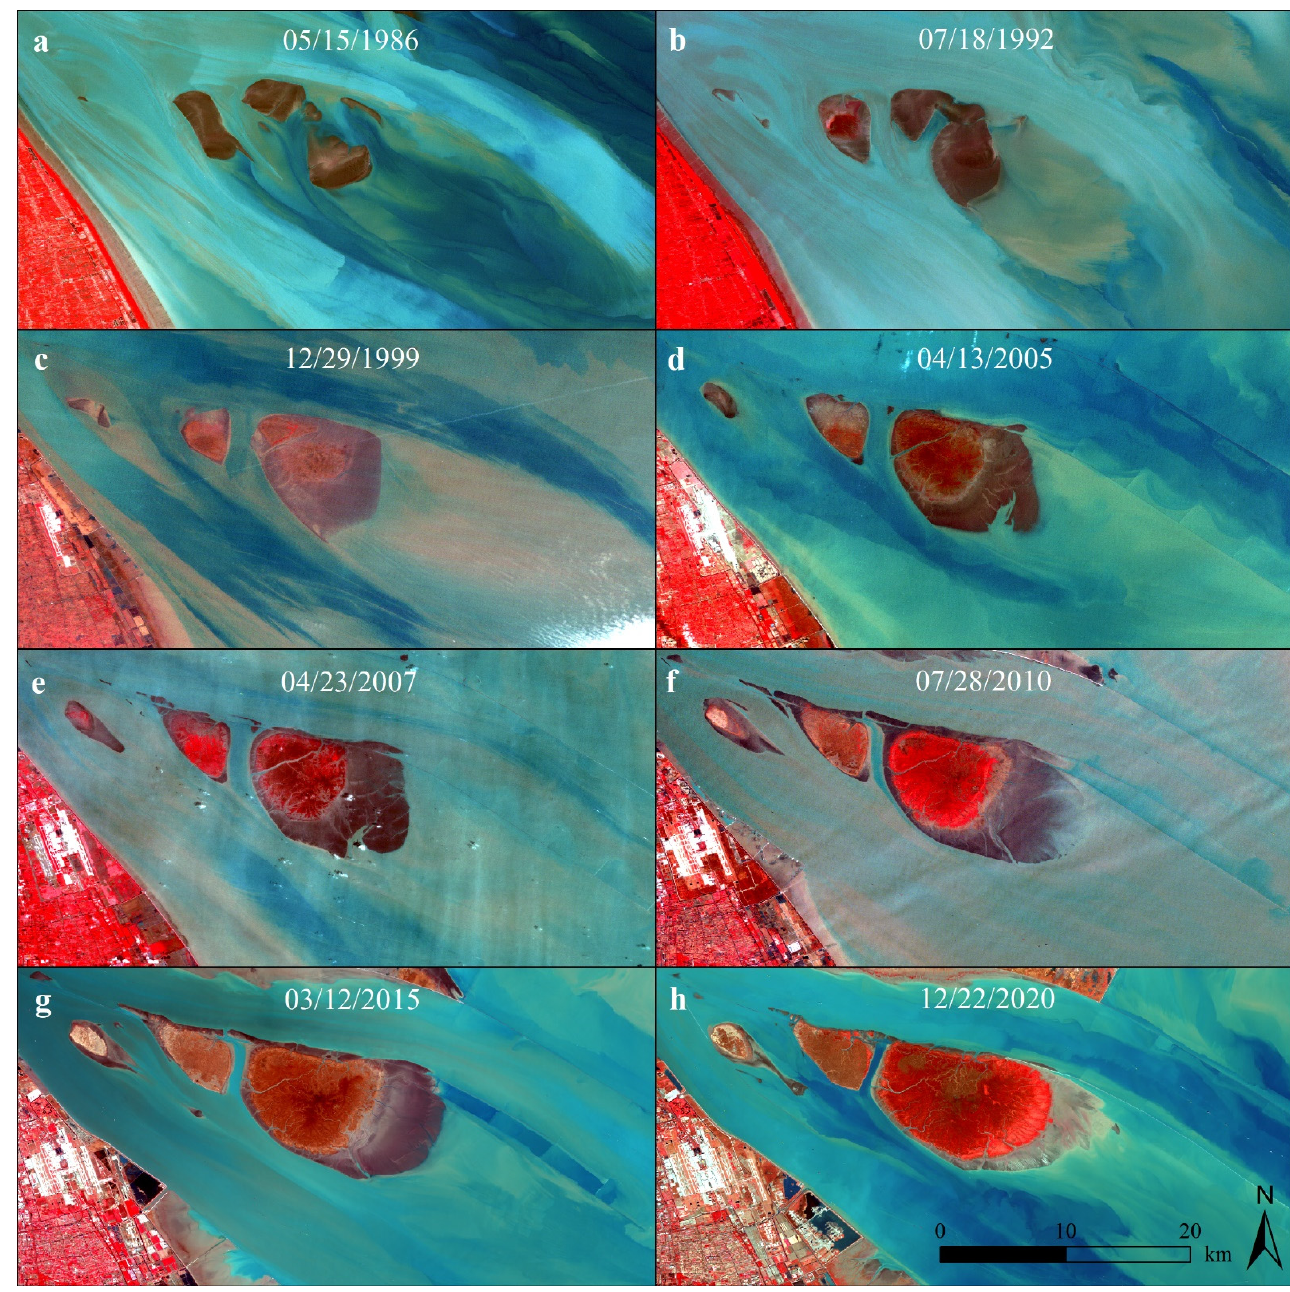
Figure 7. Landsat TM, ETM+ and OLI images of the JDS at similar low tidal levels from 1986 to 2020. The image acquired on ( a ) 15 May 1986, ( b ) 18 July 1992, ( c ) 29 December 1999, ( d ) 13 April 2005, ( e ) 23 April 2007, ( f ) 28 July 2010, ( g ) 12 March 2015 and ( h ) 22 December 2020, respectively.